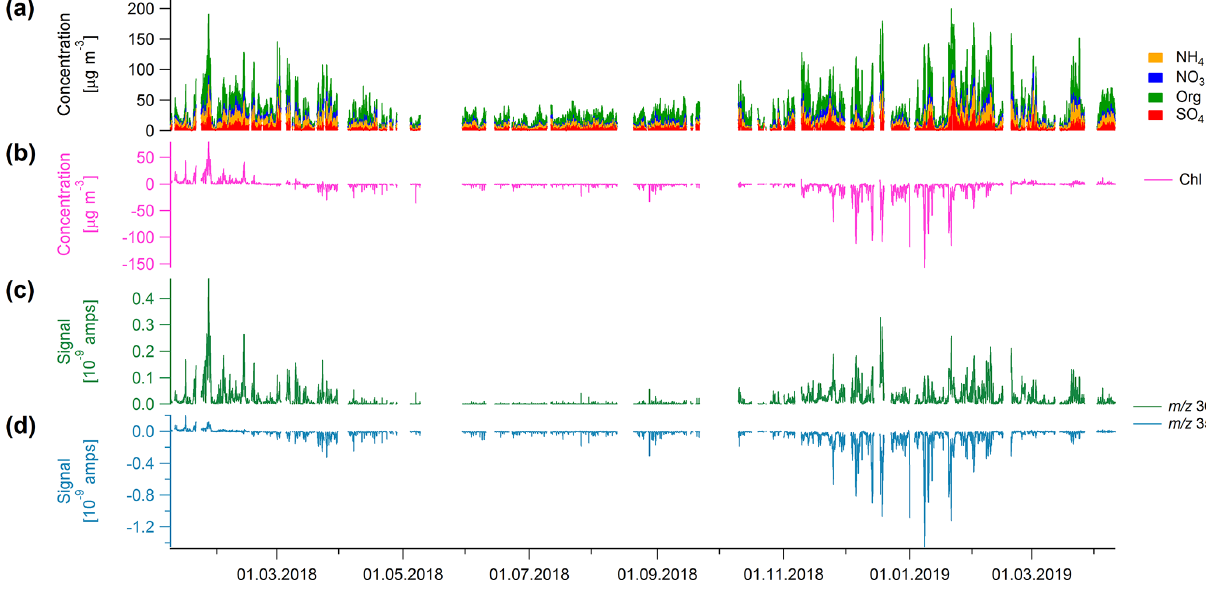
Figure 1. (a) Stacked time series of NH 4 , NO 3 , organics (Org) and SO 4 and (b) time series of chloride (in µgm − 3 ). Panels (c) and (d) show the time series of m/z 35 and m/z 36 in amps, respectively. The negative chloride signal is driven by the negative m/z 35 signal.